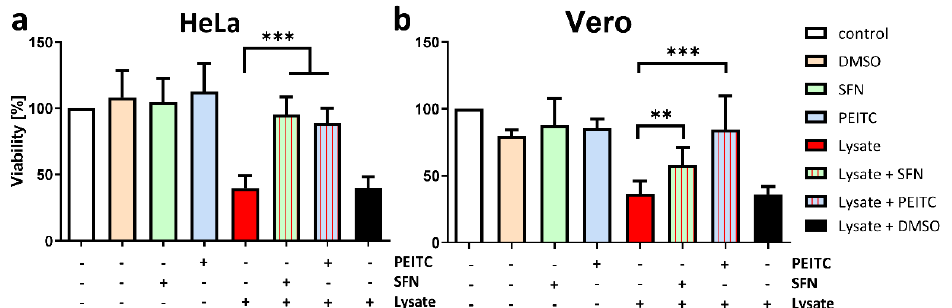
Figure 5. SFN and PEITC reduce the toxicity of V. cholerae against HeLa and Vero cell cultures. Bacterial lysates were obtained after centrifugation of 10 11 cells from culture supplemented with ITC and culture without treatment (negative control). HeLa and Vero cells (2 × 10 3 ) were grown in DMEM medium. The viability of HeLa ( a ) and Vero ( b ) cells after treatment with ITC and bacterial lysate was measured using the MTT assay. Cytotoxicity control of the vehicle (DMSO), SFN, and PEITC were assessed as indicated on the graphs. The results presented are mean values from 3 independent experiments. The significance of differences between the results and the positive control (bacterial lysate with CT) was tested using the Student’s t -test. Statistical significance is marked with asterisks: *** p < 0.001; ** p < 0.01.